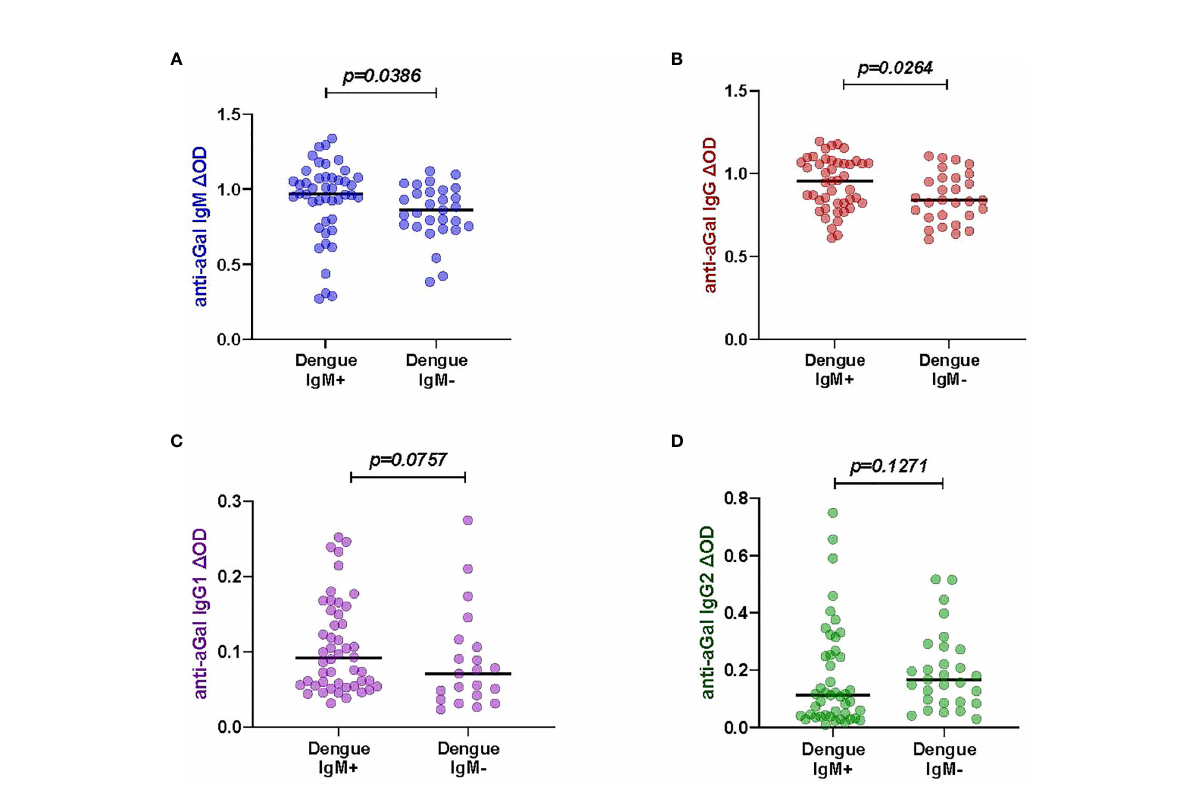
FIGURE 1 Speci fi c anti- aGal IgM, IgG, IgG1 and IgG2 in dengue patients between Dengue-IgM+ (n=45) and Dengue-IgM- (n=30). (A) Blue color - anti- aGal IgM antibody levels. (B) Brown color - anti-aGal IgG antibody levels. (C) Purple color - anti-aGal IgG1 antibody levels. (D) Green color - anti-aGal IgG2 antibody levels. Individual anti-aGal antibody levels are represented by the colored dots and horizontal red lines represent medians of group individual antibody responses Antibody levels are measured in units of OD (optical density). “ p ” values were based on the pairwise non-parametric Mann-Whitney